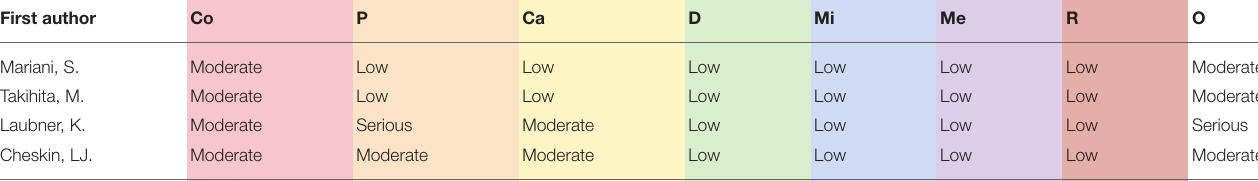
TABLE 8 | Risk of bias assessment for included non-randomized